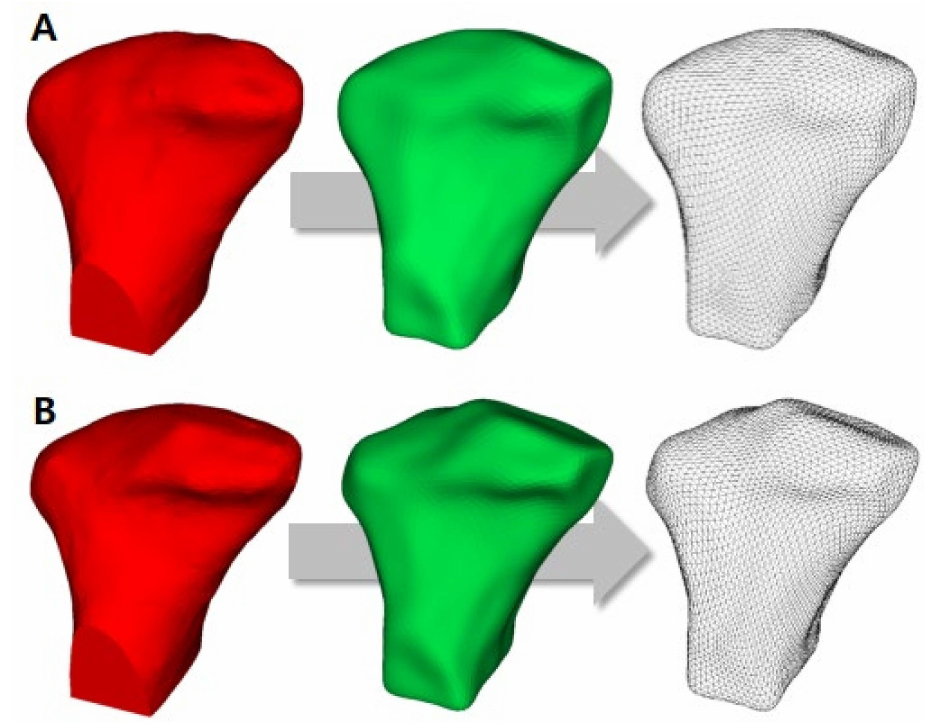
Figure 2. The left condyle model represents the surface model for the condyle cropped by region of interest. The middle condyle model represents the SPHARM-PDM model from the original mesh surface model. The right condyle model represents the final surface mesh model for the shape correspondence analysis. ( A ), pre-treatment (T1) model; ( B ), post-treatment (T2) model.